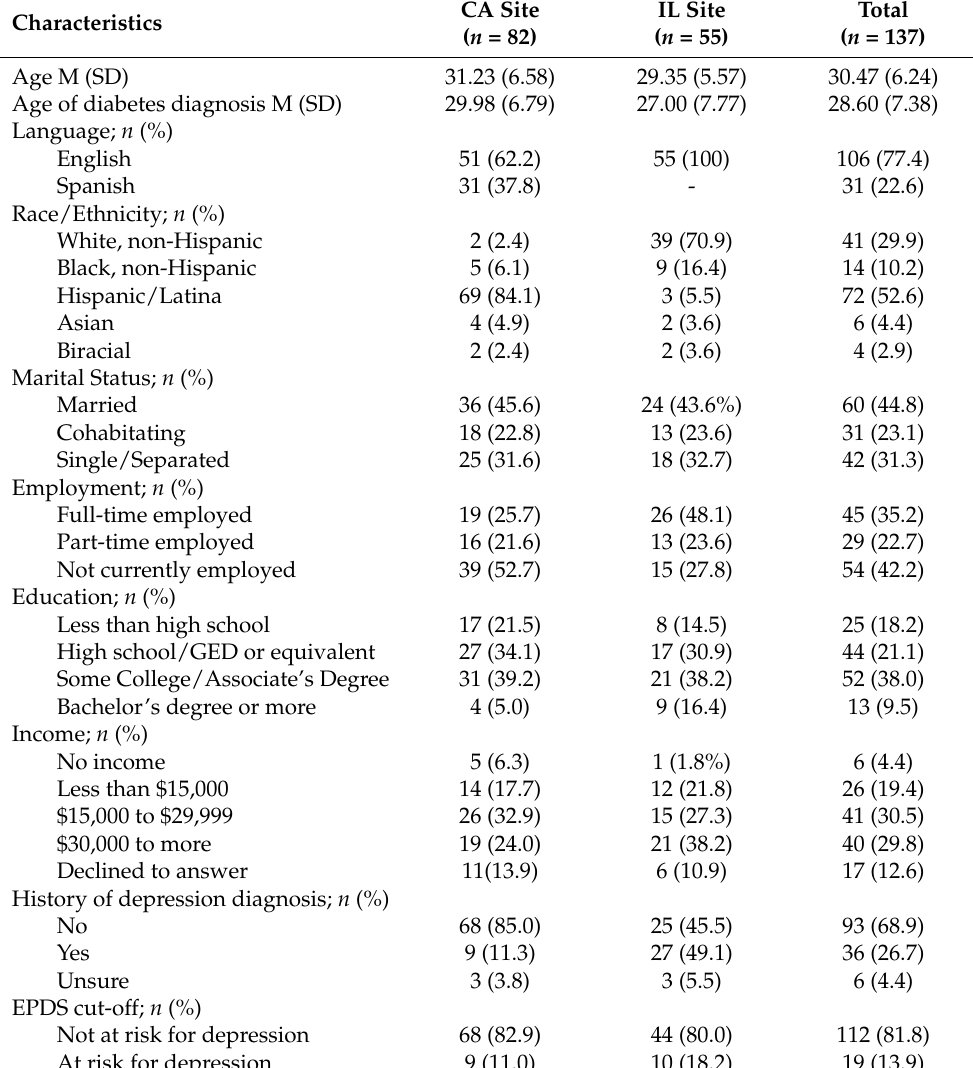
Table 1. Sample demographic characteristics ( n = 137).